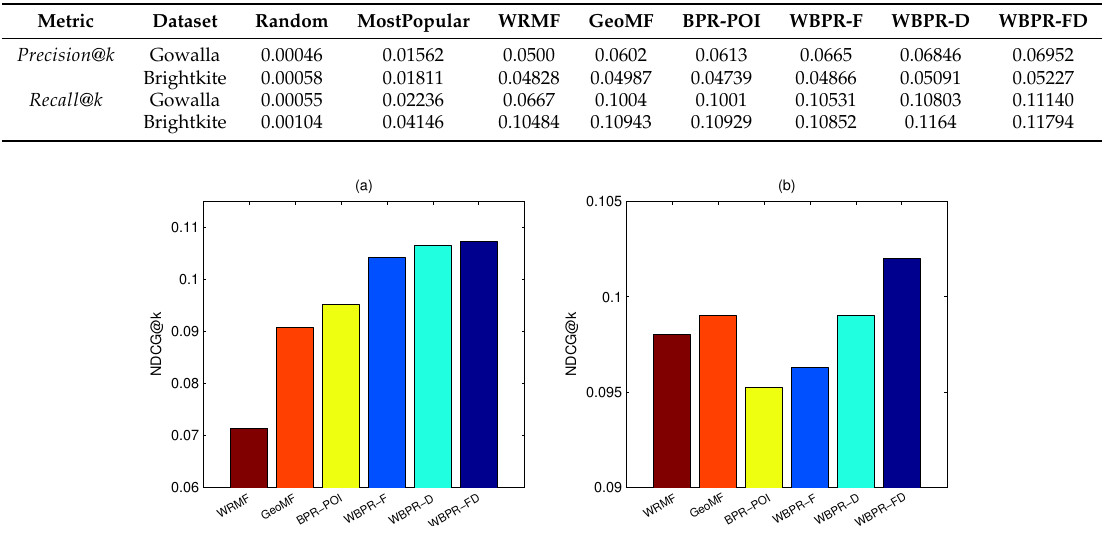
Table 2. Performance comparisons with different training datasets in the metrics of Precision @ k and Recall @ k (training = 80%, k = 5). WRMF, weighted matrix factorization method for one-class rating; BPR, Bayesian personalized ranking; WBPR-F, weighted Bayesian personalized ranking model with visit frequency; WBPR-D, weighted Bayesian personalized ranking model with geographical distance.